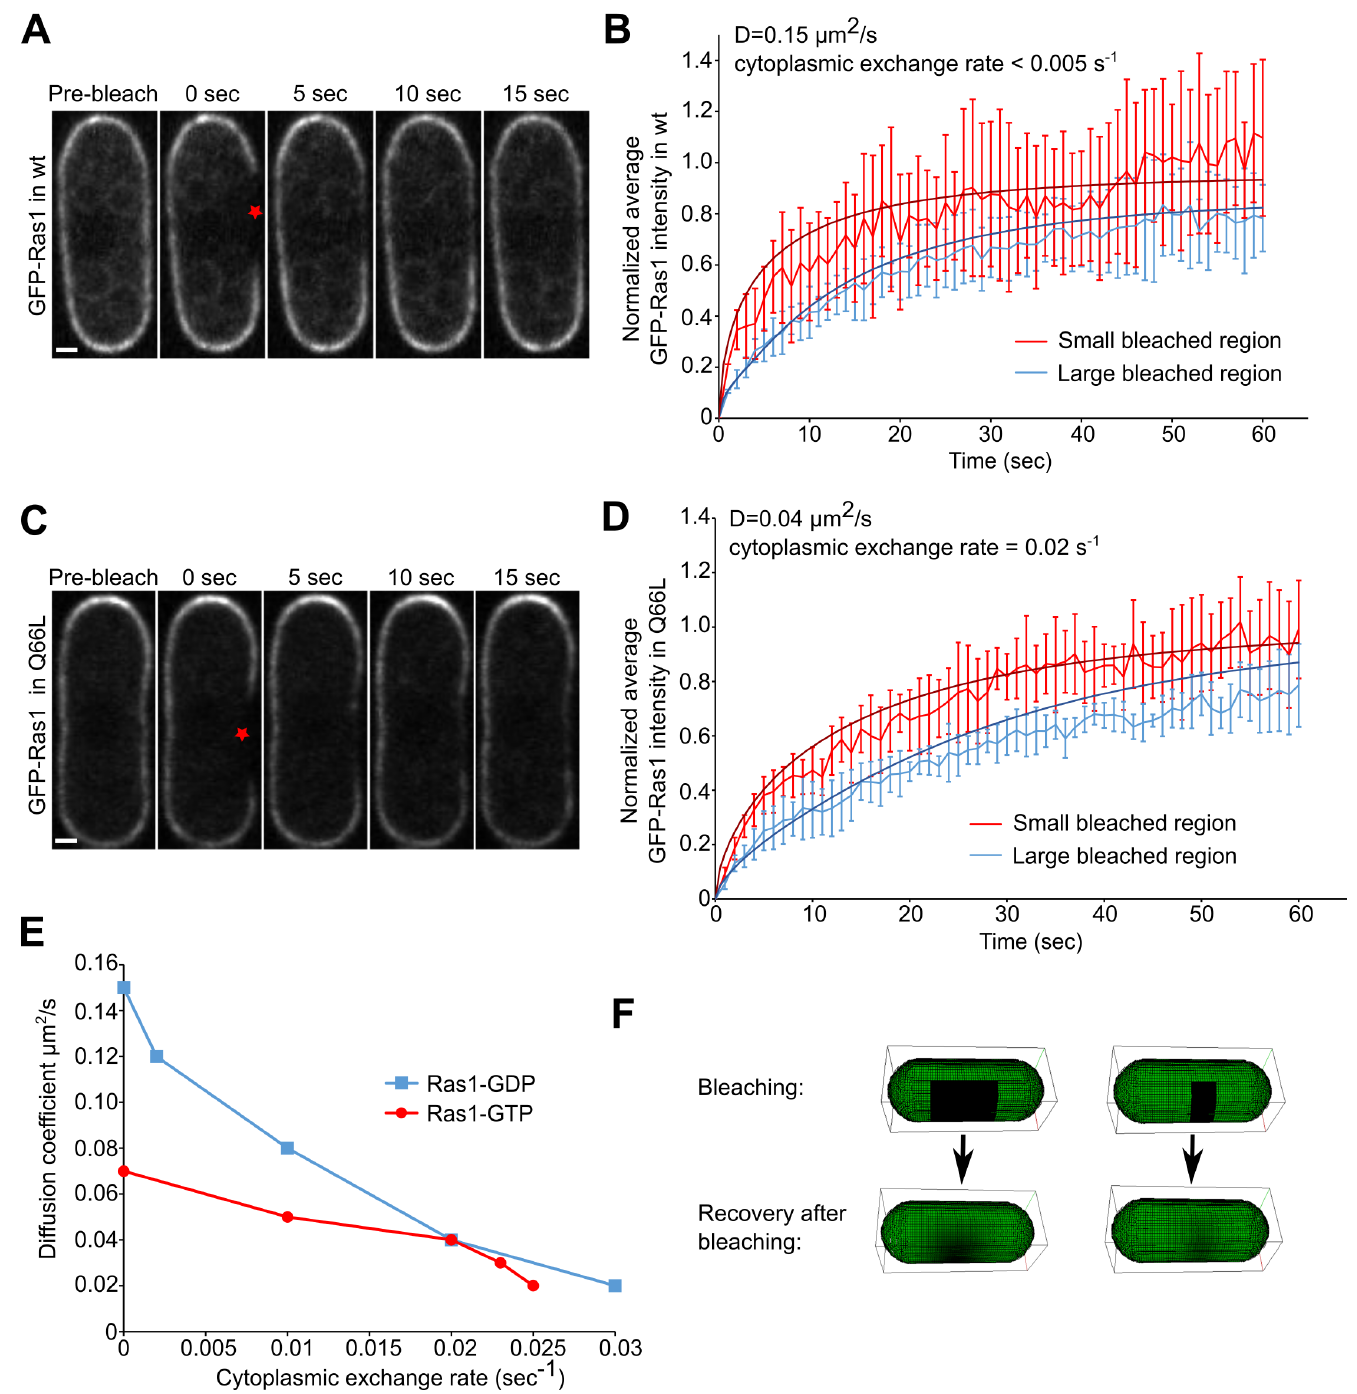
Fig 2. FRAP studies of Ras1 membrane diffusion. (A) Snapshots of FRAP of GFP-Ras1 at the sides of a WT cell (bleach region indicated by star). The scale bar is 1 μm. (B) Recovery of GFP-Ras1 at the sides of WT cells bleached over large (4.0 ± 0.2 μm) and small (1.5 ± 0.2 μm) regions, average of 5 cells. Measurements are made along the cell membrane, over the whole width of the bleached region. Continuous curves show fit by model with D = 0.15 m m 2 s (cid:0) 1 and no cytoplasmic exchange. (C) Snapshots of FRAP of GFP-Ras1 at the sides of GFP-ras1 Q66L cells. The scale bar is 1 μm. (D) Same as panel B for GFP-Ras1 at the sides of ras1 Q66L cells and fit with D = 0.04 m m 2 s (cid:0) 1 , and uniform cytoplasmic exchange rate 0.02 s (cid:0) 1 . (E) Plot showing acceptable set of diffusion coefficients and cytoplasmic exchange rates that can be fitted to the FRAP data of panels A-D for both large and small bleached regions for WT (blue squares) and ras1 Q66L (red circles). (F) Snapshots of FRAP simulations of wide (left) and narrow (right)